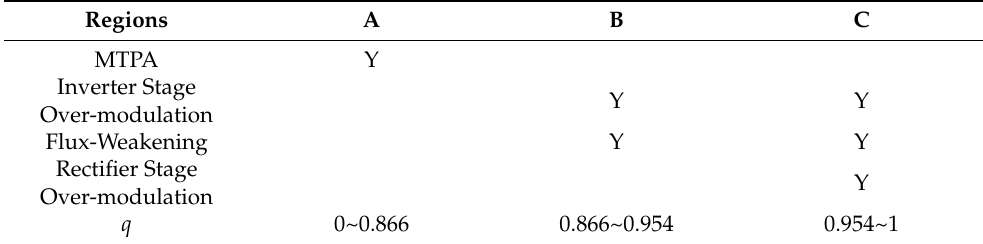
Table 1. Control strategies or modulation methods activated in different regions. Regions